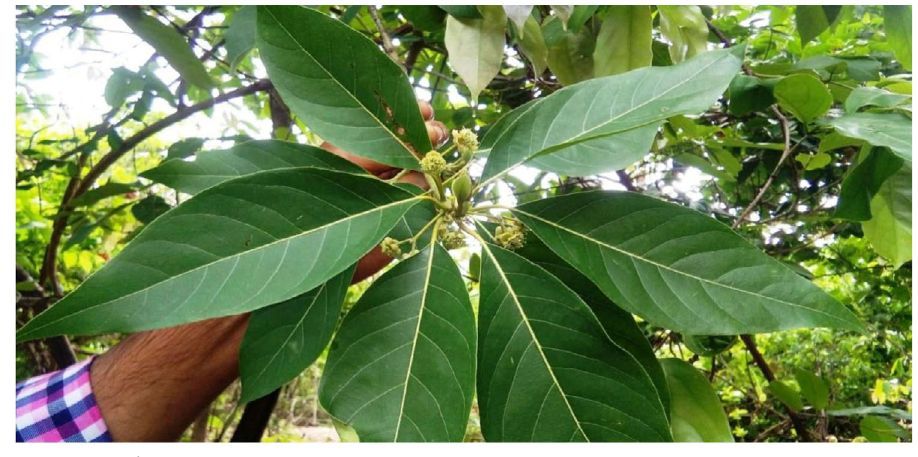
Fig. 1. Litsea Table 1. Geographical characters of sample collection locations Location Geographical Altitude